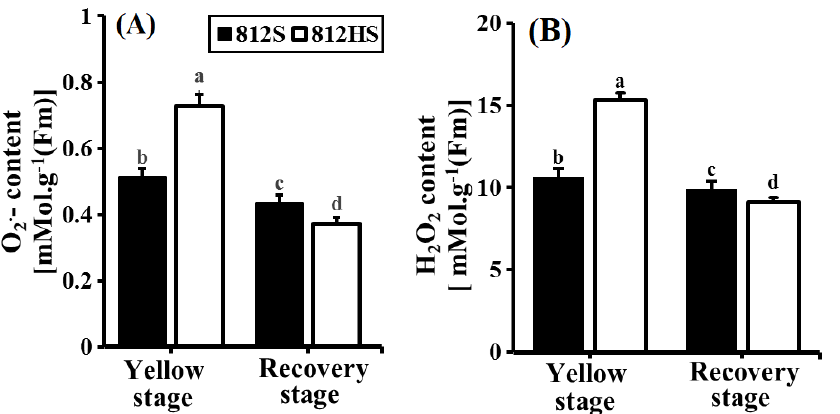
Figure 7. Effects of photooxidation of O 2 • – content ( A ) and H 2 O 2 content ( B ) in the leaves of rice mutant 812HS and its wild-type 812S. Data are mean ± SD ( n = 3). Different small letters indicate significant differences. p < 0.05, using the t -test.